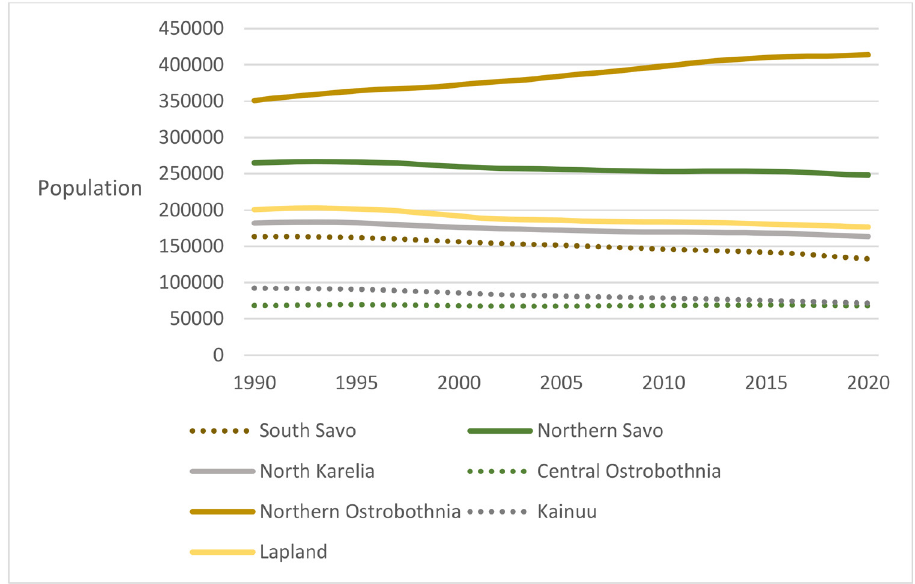
Fig. 2. Population by region ( maakunta ) in 1990–2020 (Source: Statistics Finland 2022). Interview data of regional development